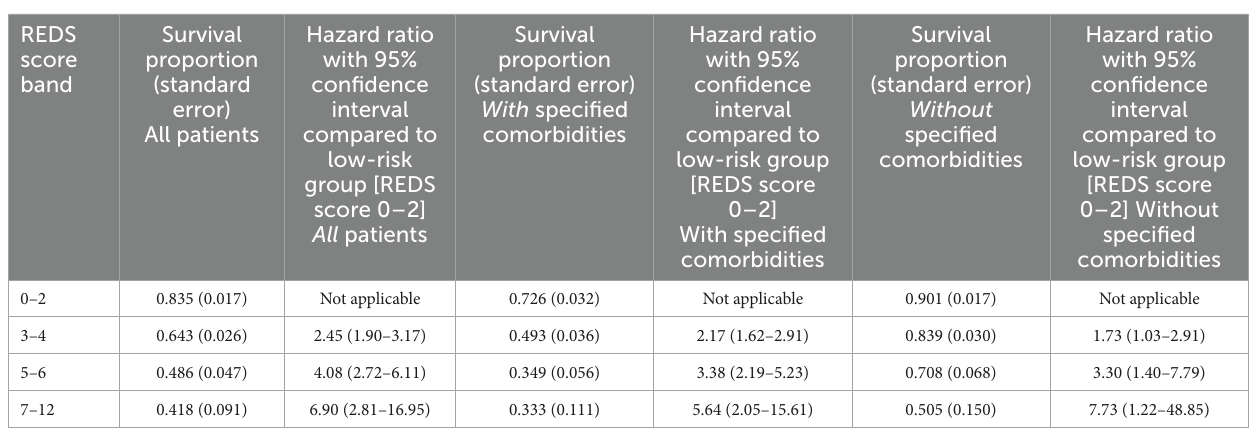
TABLE 7 Survival proportion and hazard ratio compared to low-risk group at 180 days by the REDS score bands, in all patients, those with specified * co-morbidities and those without specified *